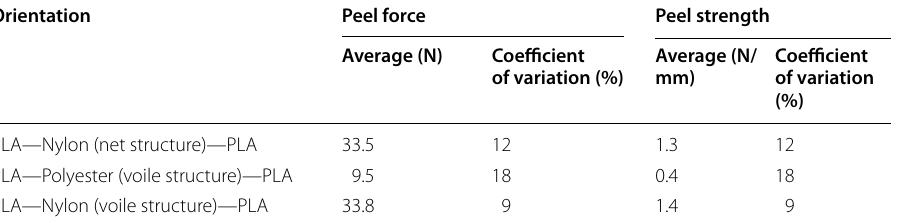
Table 8 Average peel forces and strengths and coefficients of variation for the three bonded ME printed polymer–textile composites